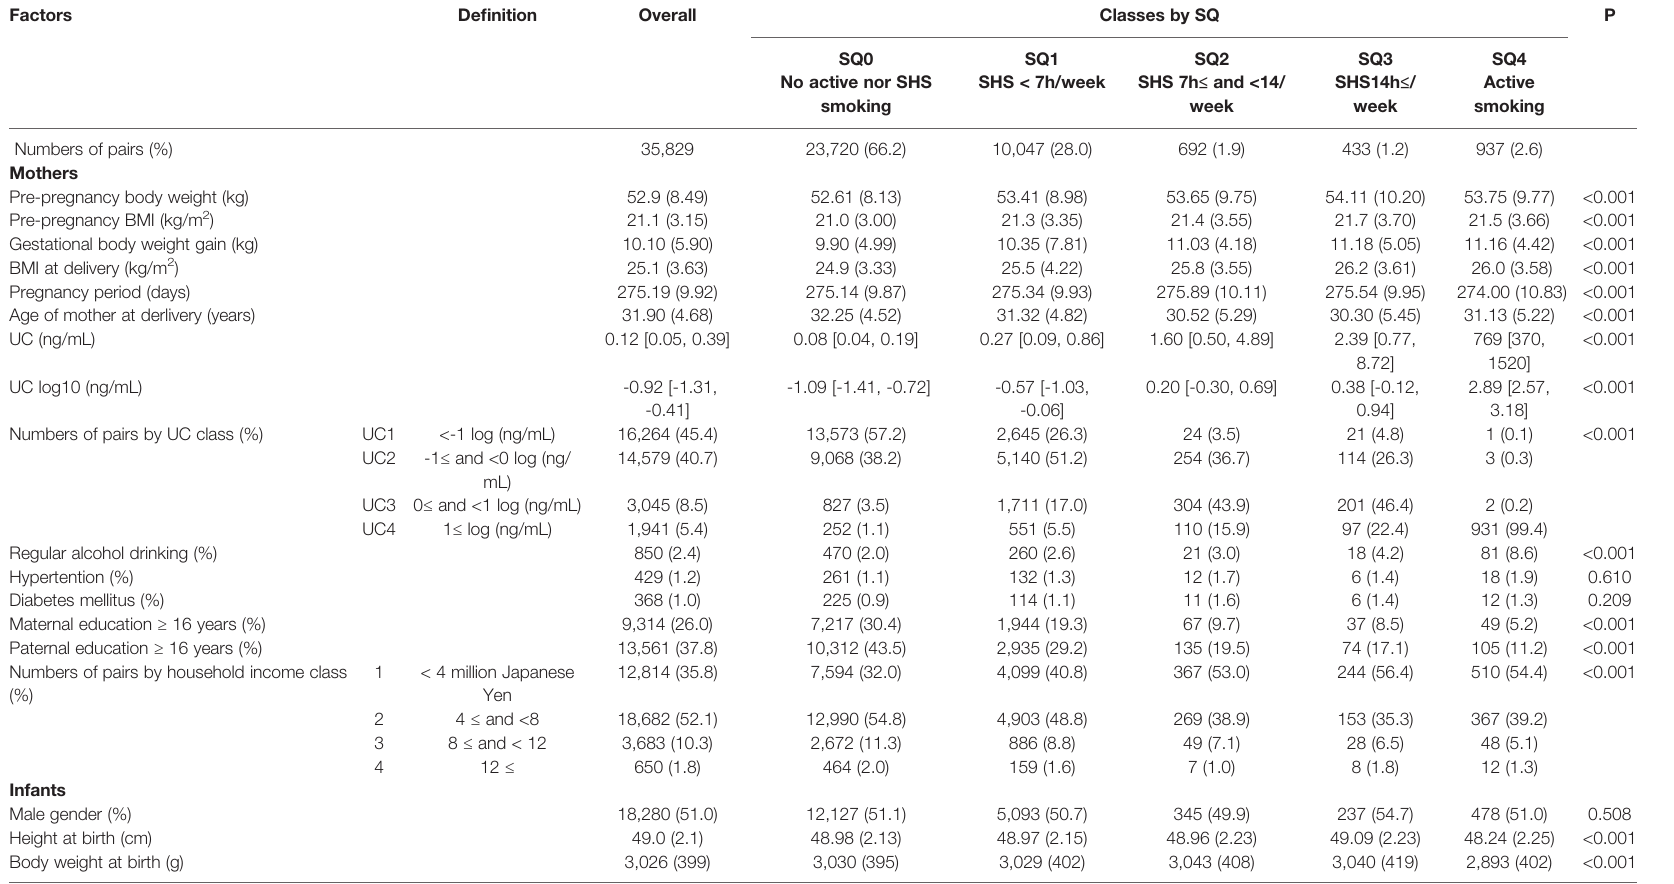
Data are number (%), mean (standard deviation), or median [25%, 75%]. UC, urine cotinine; BMI, body mass index; SQ, smoking questionnaire; SQ0, SQ class 0; SQ1, SQ class 1; SQ2, SQ class 2; SQ3, SQ class 3; SQ4, SQ class 4; SHS, second-hand smoke; P, probability by